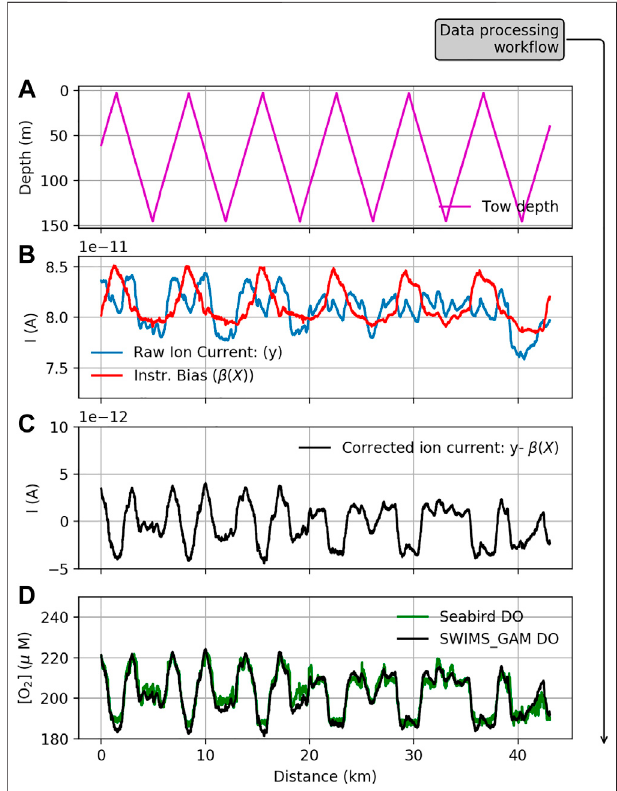
FIGURE 7 | Sequence showing the SWIMS tow and bias correction using the generalized additive model (GAM). Panel (A) reveals the depth recorded by the Triaxus CTD during vertical tows; panel (B) shows the raw signal recorded for oxygen at m/z (cid:3) 32 and the estimate of instrumental bias. Panel (C) shows the corrected ion current, and panel (D) shows the calibrated ion current in O 2 concentration units, alongside the Seabird DO